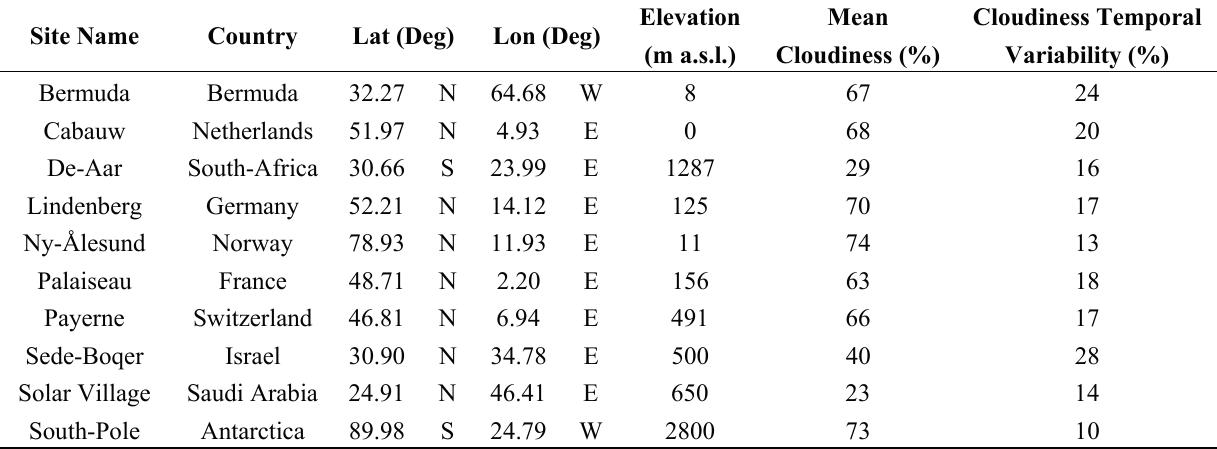
Table 1. The Baseline Surface radiation Network (BSRN) sites used in the study. The cloudiness temporal variability indicates the percent of changes in cloudiness (from cloudy to cloudless and vice versa ) in the total number of